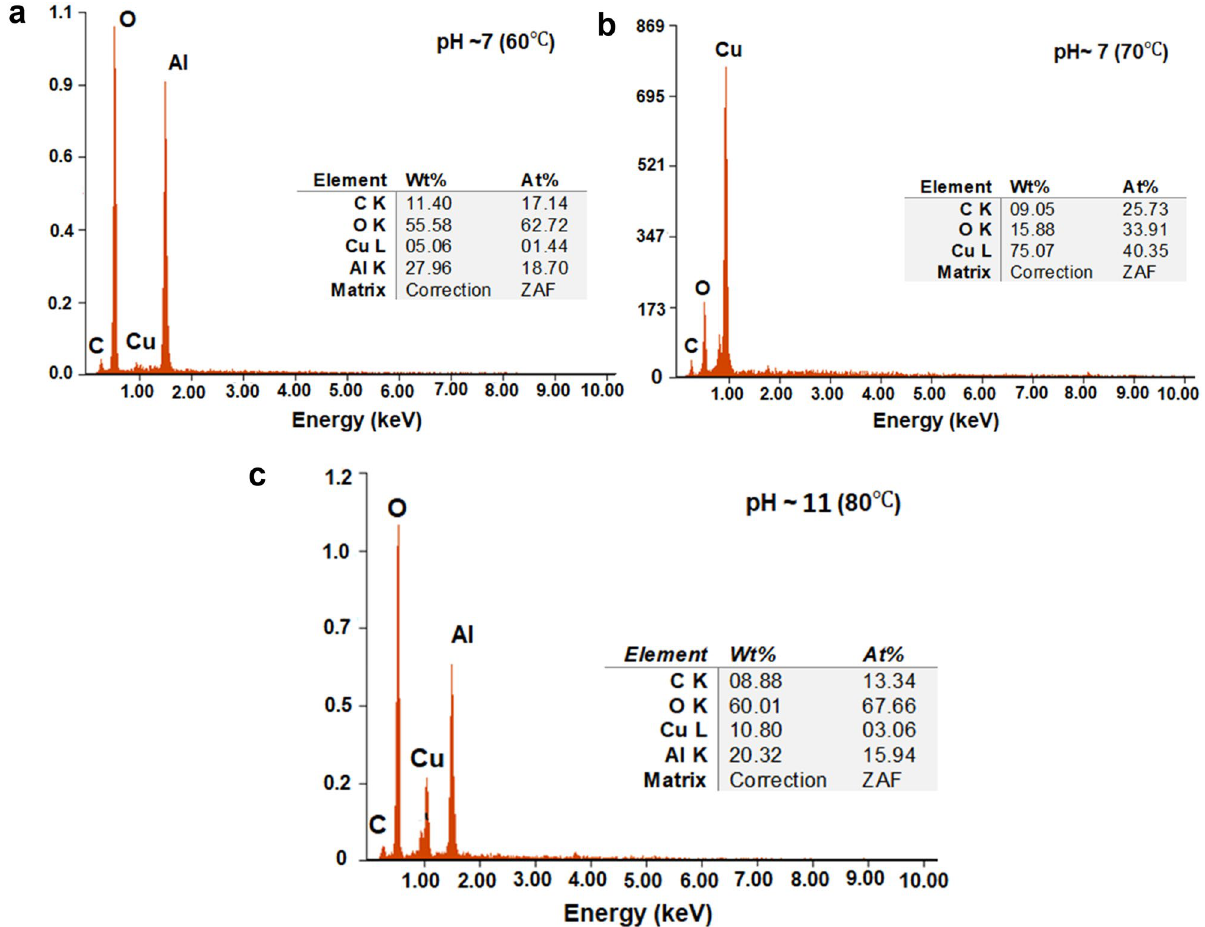
Figure 7. The corresponding EDX analyses for Cu-based oxide nanostructures prepared at ( a ) 60, ( b ) 70 and ( c ) 80 °C.